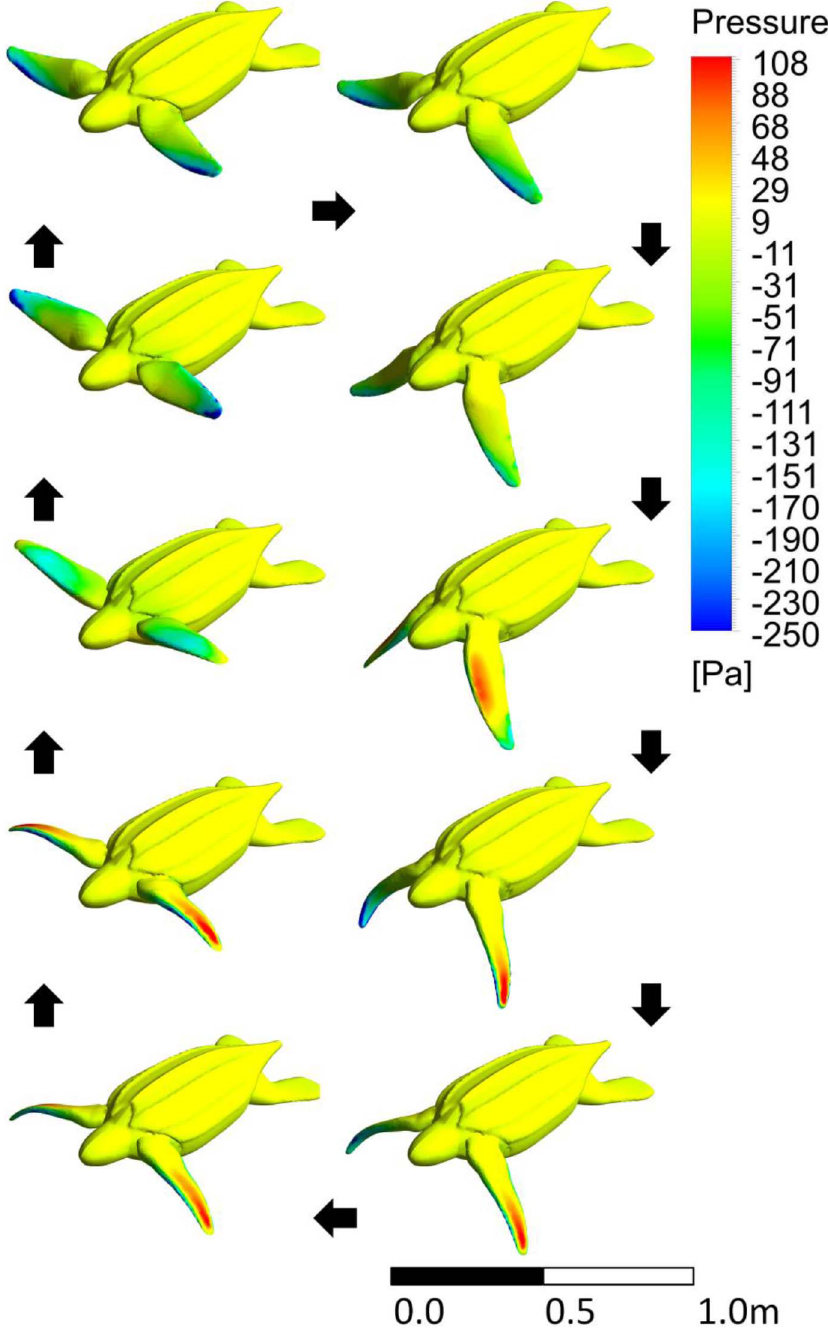
Figure 8. The pressure contours on the juvenile turtle as it moves through one stroke period. Black arrows indicate the direction of the image sequence. This is an orthographic projection. The third image in the left column represents one of the high negative thrust points recorded at the middle of the bottom phase.